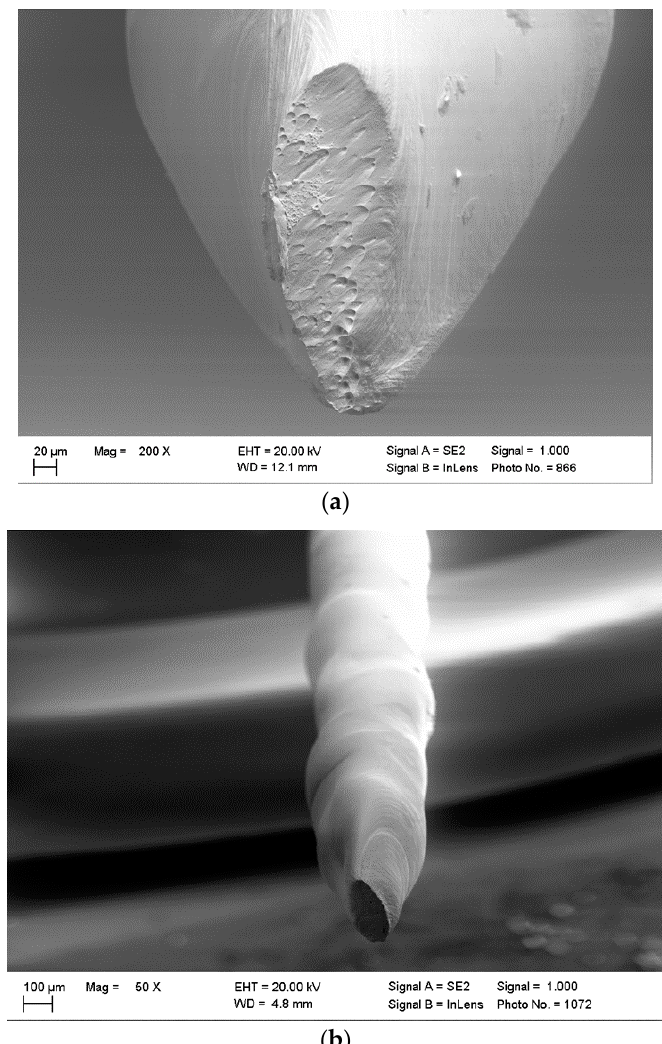
Figure 6. SEM images of ( a ) a representative fracture surface of an oligo-crystalline wire and ( b ) overview of the wire surface with bulges after testing (fracture at 1.995 million cycles). The cold drawn wires exhibited different types of failure, depending on the number of cycles to failure. A typical fatigue fracture surface occurred after failure at 530,000 cycles (Figure 7a), where no pronounced necking was visible. On wires with fractures after, up to, 4000 cycles (Figure 7b), the same type of fracture surface, such as that in the solution annealed wires, was observed. The necking on these wires caused a lateral contraction of the cross section. A smaller cross section led to higher local stresses and, thus, finally, to fracture. Due to grain rotation after cold drawing, the initial diameter (0.5 mm) of the wires was distinctly decreased to 0.374 (±0.047) mm. The smallest measured diameter was 0.3 mm, which was approximately a 40% decrease from the initial diameter. Thus, necking was mainly caused by cold drawing in this case. In contrast, necking of the solution annealed wires happened mainly during the cyclic test.